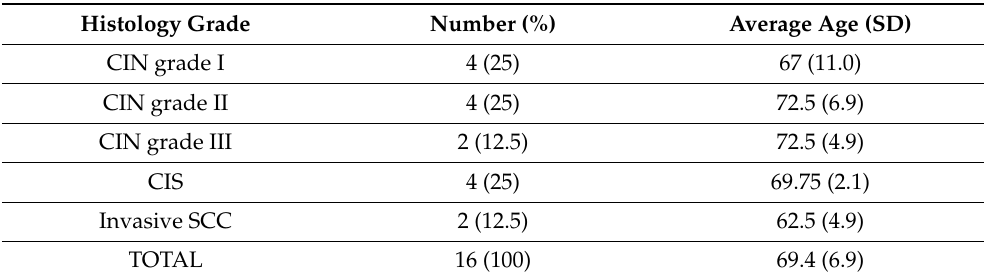
Table 1. Histology grades and age of patient at time of OSSN diagnosis. CIN = conjunctival intraepithelial neoplasia. CIS = carcinoma in situ. SCC = squamous cell